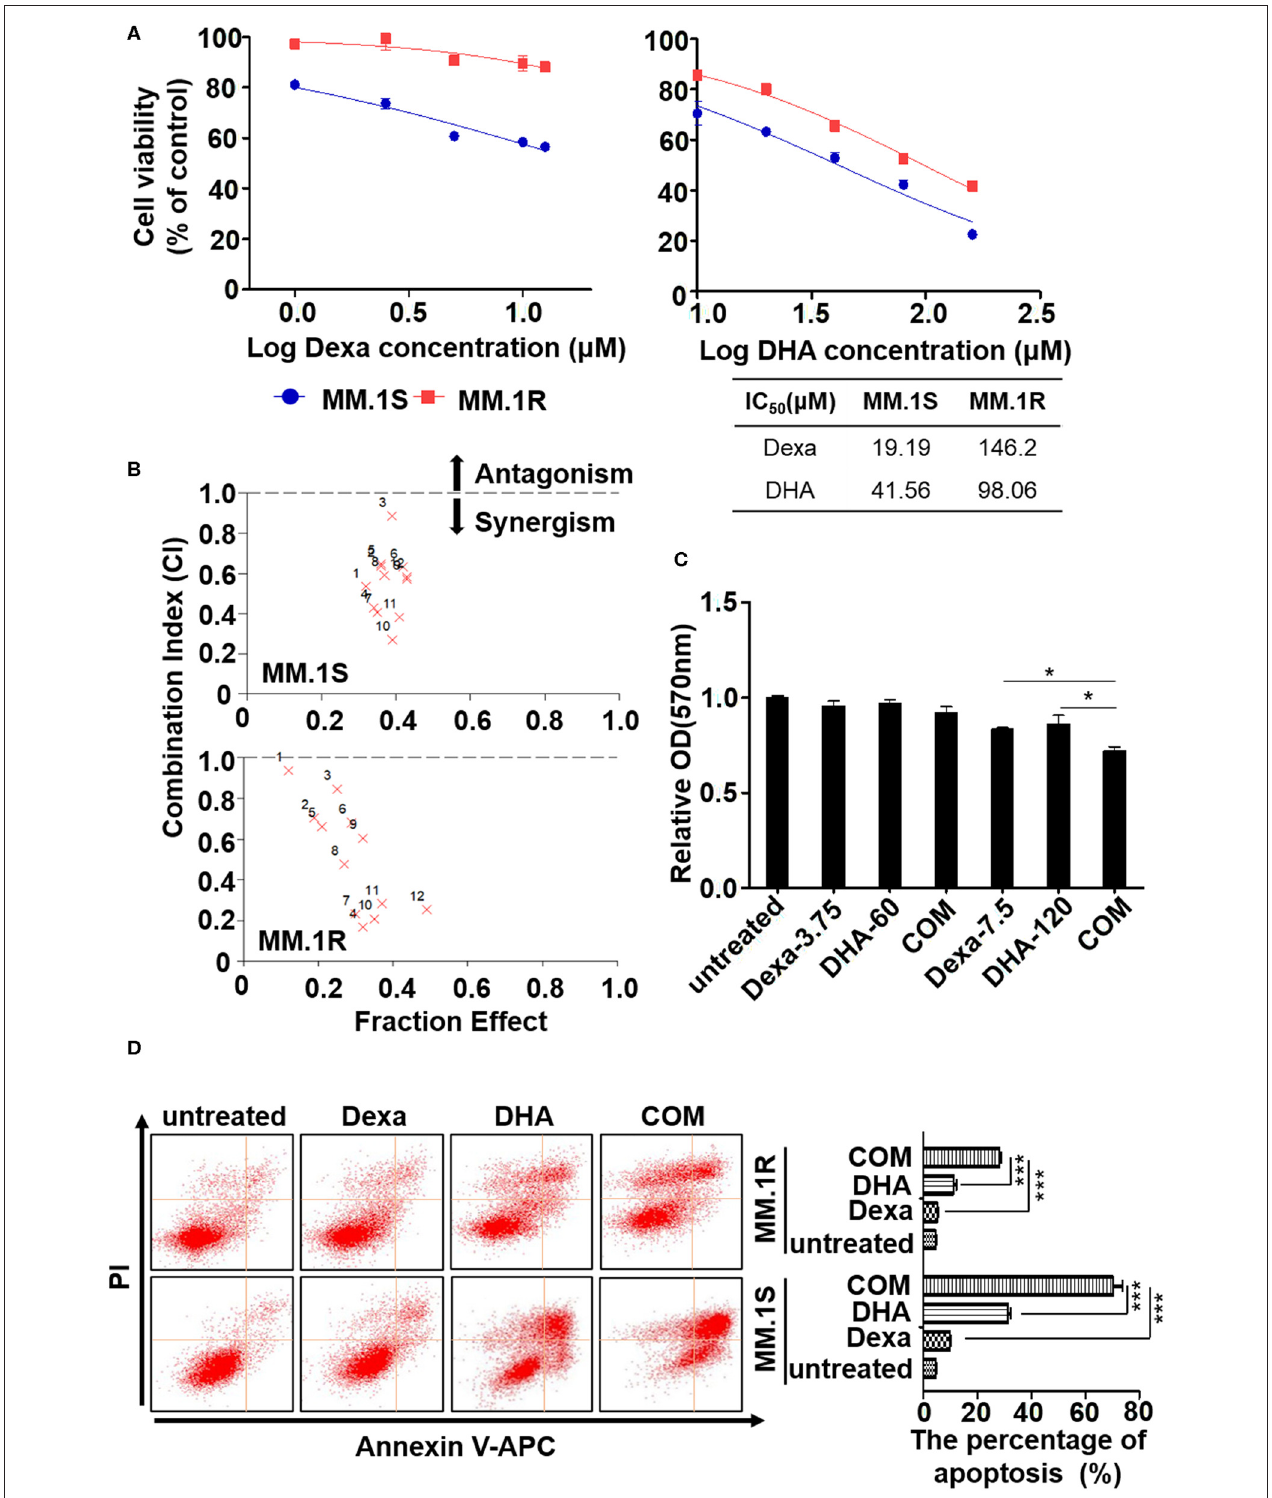
FIGURE 4 | DHA overcomes dexamethasone resistance in multiple myeloma. (A) The MTT assay. DHA suppresses the proliferation of ARP1 and H929 cells. (B) DHA synergistically enhances the effect of Dexa. (C) The MTT assay. The combination of DHA and Dexa significantly inhibits the growth of CD138 positive cells. (D) The apoptosis of MM.1S and MM.1R cells was measured by staining with Annexin V and PI, which was followed by flow cytometry analysis. * P < 0.05, *** P < 0.001.